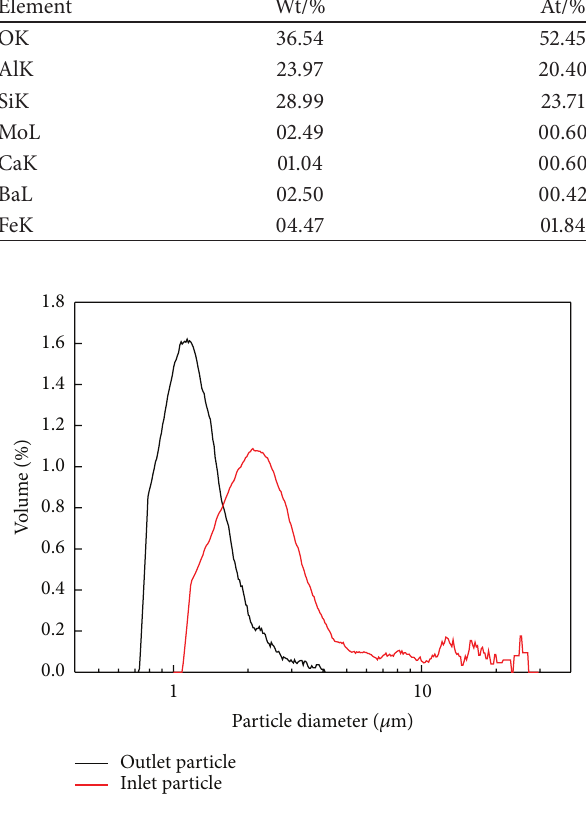
Figure 9: PSD measured by the Coulter counter